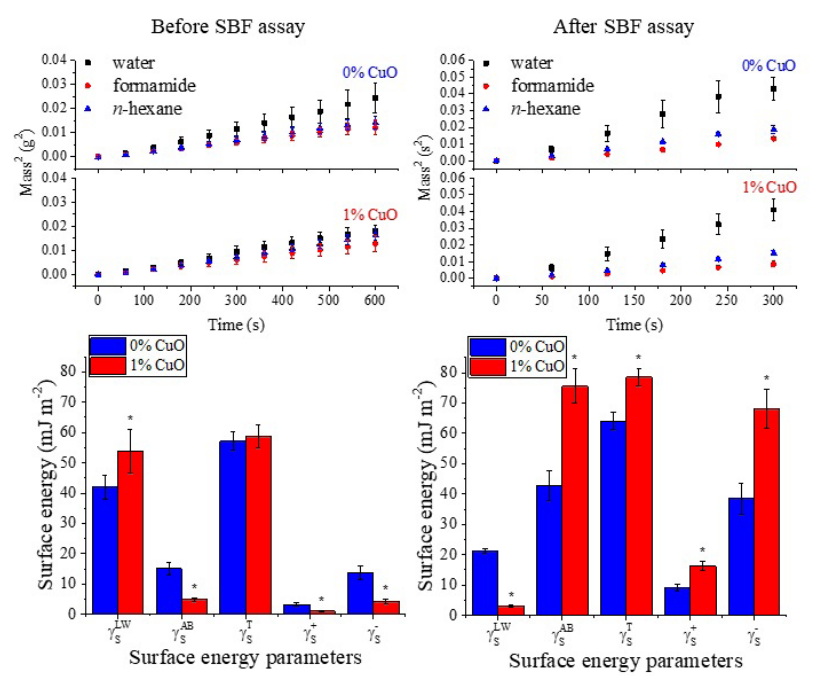
Figure 1. Average capillary rise with respect to time for three different liquids in bioactive glass powders before and after 7 days of immersion in SBF solution (top). The surface energy parameters calculated from the bioactive glasses before and after immersion in SBF solution using the Washburn capillary rise method (bottom). * Significant difference ( n = 3; p < 0.05) compared with the sample without CuO. Table 2. Composition of the CuO-containing bioactive glasses obtained by wavelength-dispersive X-ray fluorescence (WDXRF).